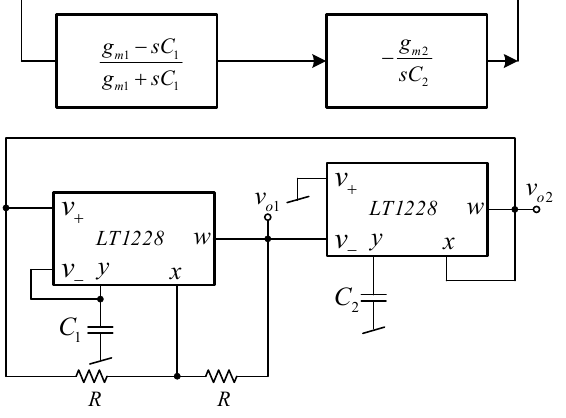
Figure 24. Proposed quadrature sinusoidal oscillator.